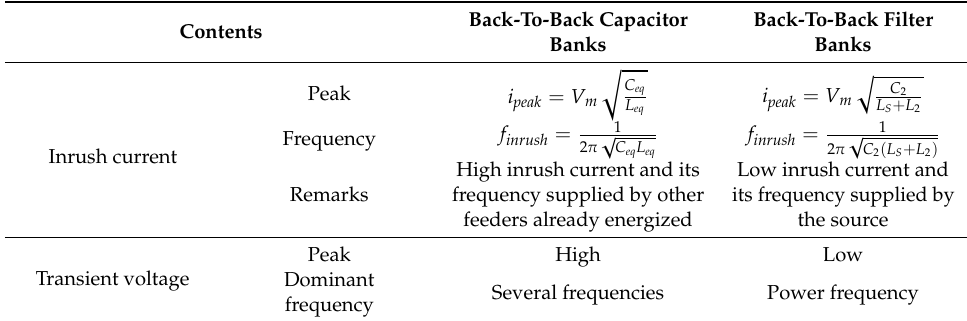
Table 1. Comparing the inrush current and transient voltage between back-to-back capacitor banks and back-to back filter banks.